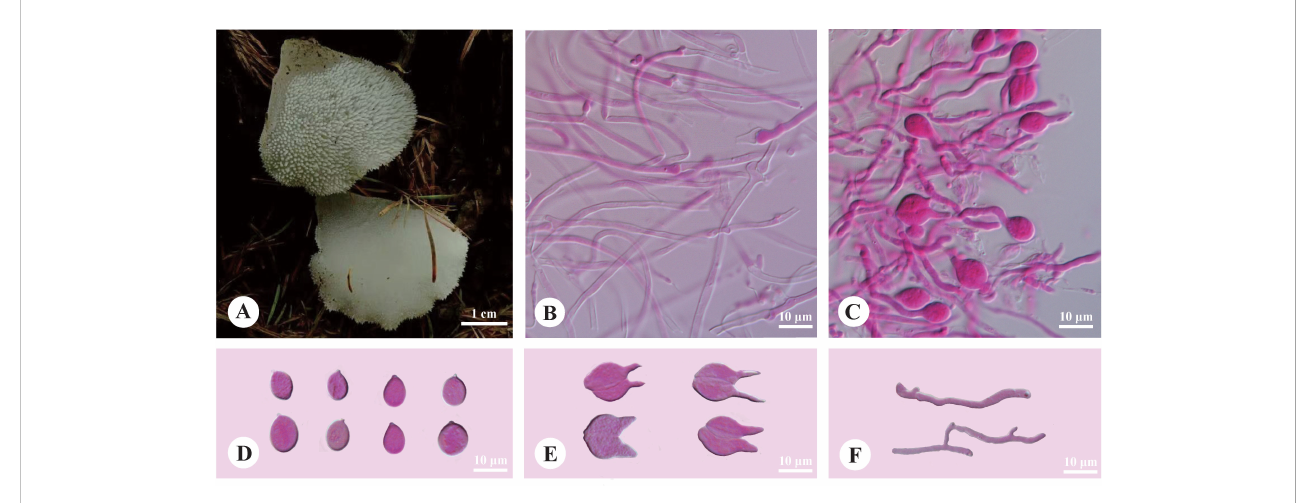
FIGURE 4 Basidiomata and microscopic structures of Pseudohydnum sinobisporum (holotype, SYL 2307). (A) Basidiomata; (B) Tramal hyphae; (C) A section of hymenium; (D) Basidiospores; (E) Basidia; (F) Hyphidia.